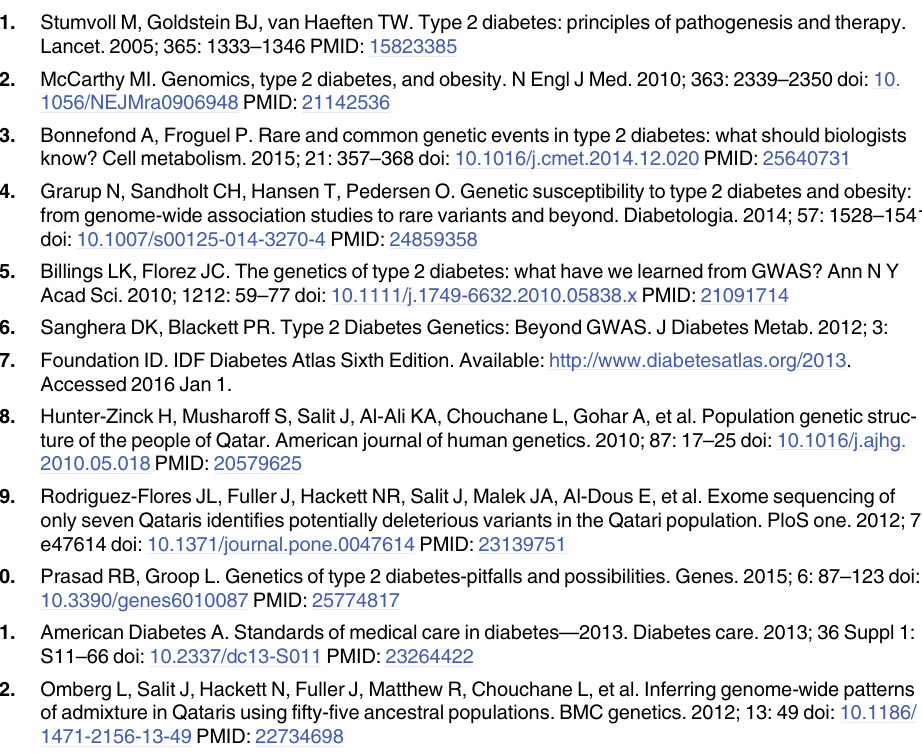
S1 Table. Type 2 Diabetes Risk Allele SNPs. S2 Table. Statistical Power to Detect Associations with Type 2 Diabetes for Known Risk Alleles (with references). S3 Table. Demographics of Type 2 Diabetic Cases and